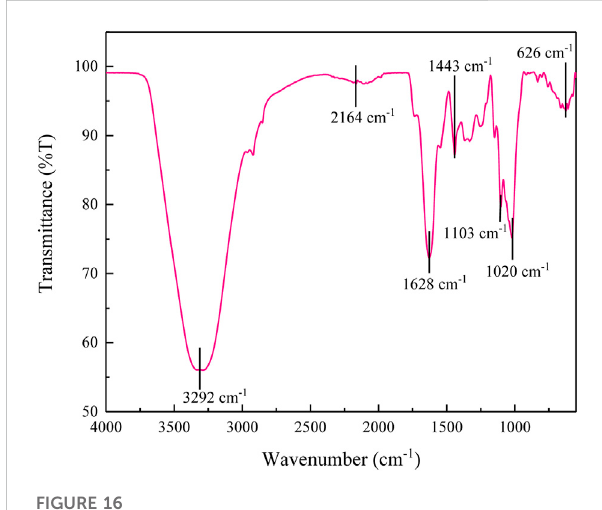
FIGURE 16 FTIR spectra of grafted okra mucilage.